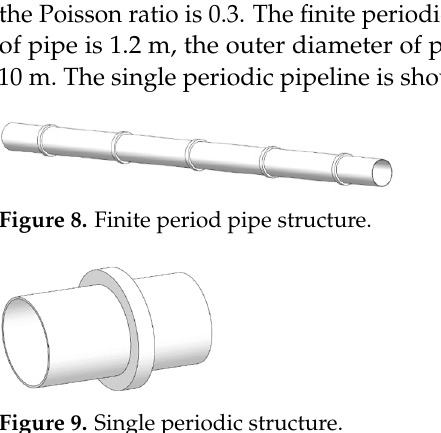
Figure 10. Common pipes. Table 3. The cushioning performance of periodic pipeline under different working conditions. Height (mm) Width (mm) Input Terminal Vi- bration Level (dB) Output Terminal Vi- bration Level (dB)